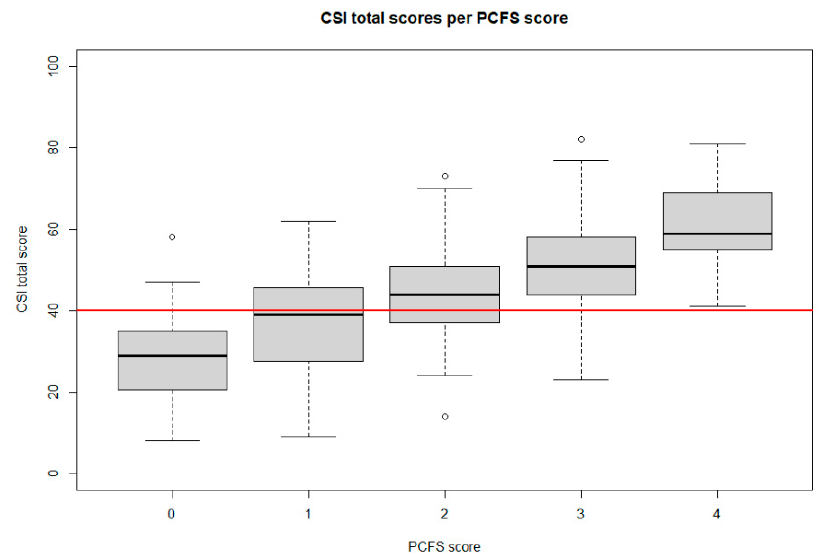
Figure 1. Boxplot of total score on the CSI by PCFS Scale score for all respondents. The red line is presents the cut-off value of the CSI at 40/100 to denote a person as having symptoms of central sensitisation. Abbreviations. CSI: Central Sensitization Inventory, PCFS: Post-COVID-19 Functional Status Scale.